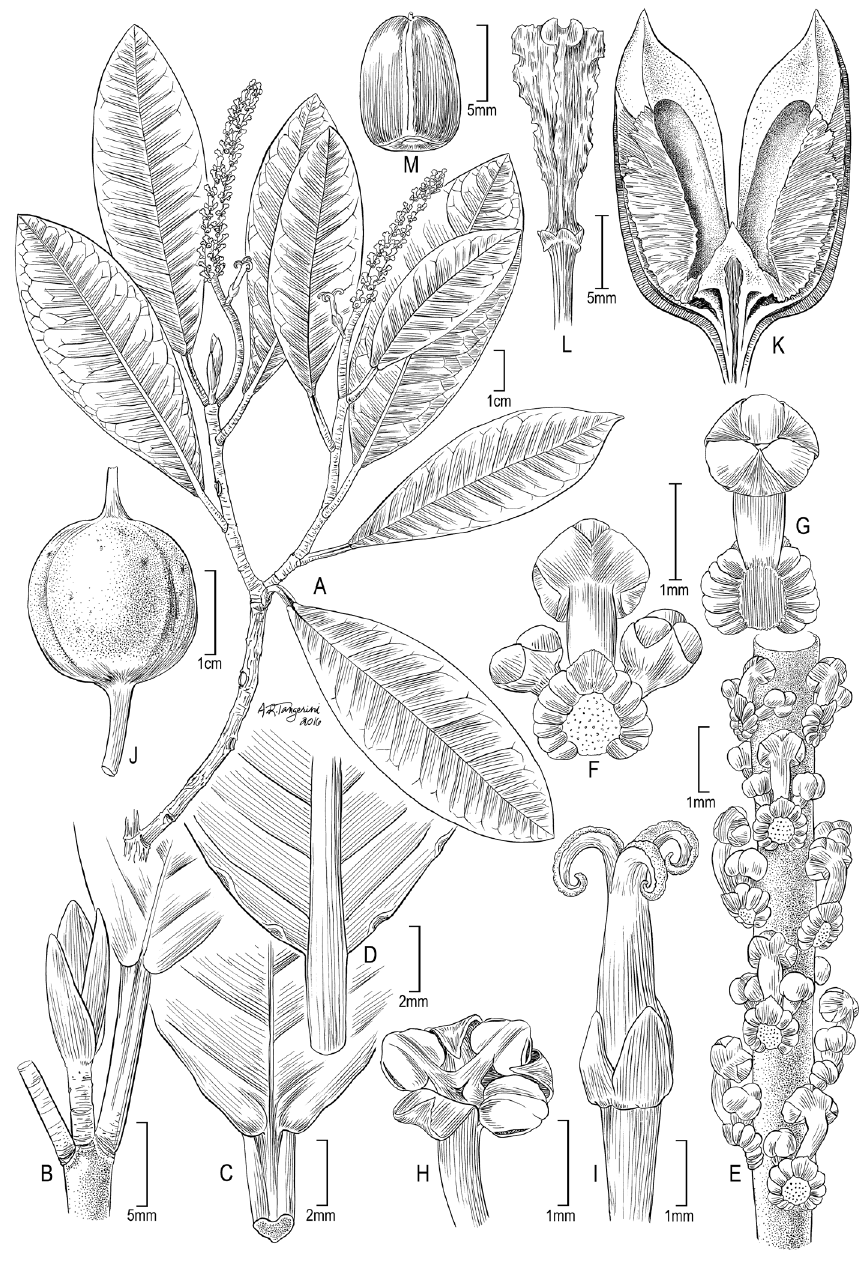
Figure 1. Illustration of Incadendron esseri. A Habit B Shoot tip C Leaf base (adaxial) D Leaf base and marginal glands (abaxial). E Staminate subinflorescence F Staminate cymule (distal view) G Staminate cymule (proximal view, without lateral buds) H Staminate flower I Pistillate flower J Fruit K Mericarp valve L Columella M Seed (ventral face). (Source: A–G Calatayud et al. 4711 , MO; H–I Monteagudo et al. 4458 , US; J Vásquez & Valenzuela 37638 , MO; K–M Monteagudo & Ortiz 4605 ,